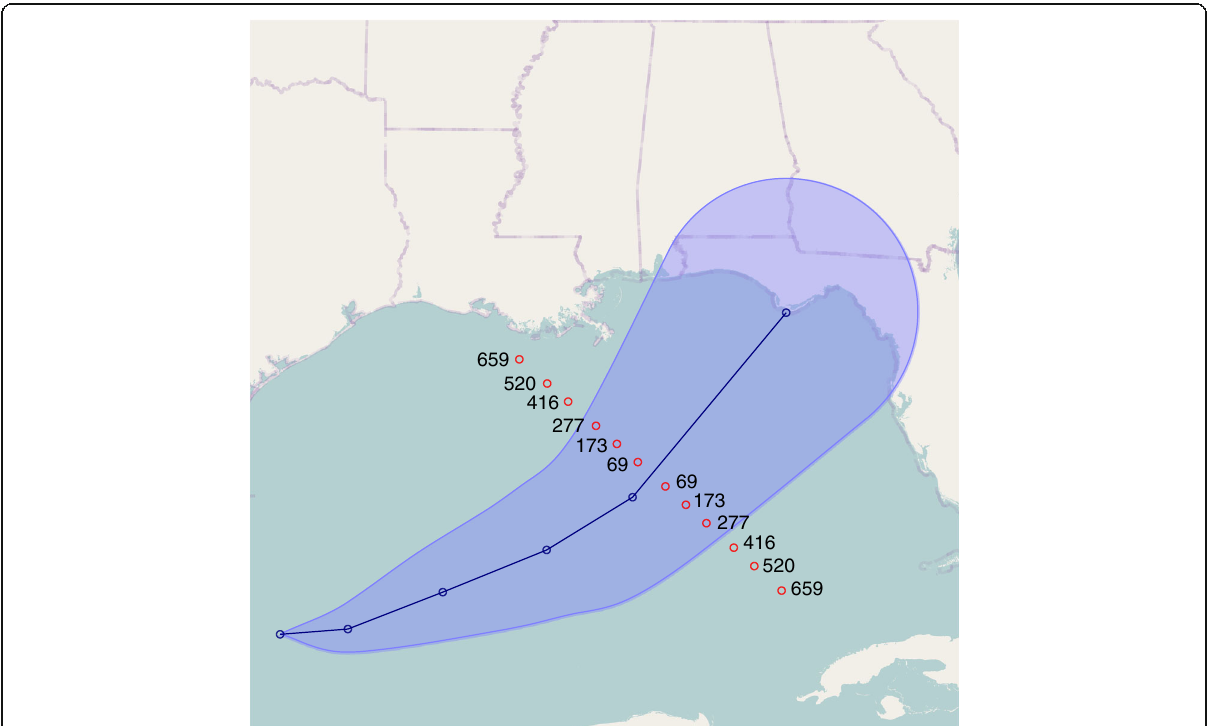
Fig. 3 An example of the cone visualization, shown with the 12 possible oil rig locations. Only one location was presented on each trial (and km were not presented)